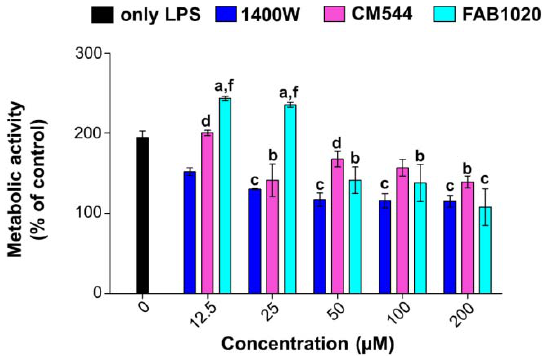
Figure 3. Cell metabolic activity of LPS-stimulated human monocytes (MTS assay). Cell cultures were exposed to 1400 W, CM544 or FAB1020 for 24 h. Bars represent the percentages of cell metabolic activity in the presence of compounds (0–200 µ M) in human monocytes stimulated with 0.25 µ g/mL of LPS. OD values in control cultures (untreated cells, not shown) are set to 100%. 0 µ M = cells stimulated with LPS alone. a = p < 0.01, b = p < 0.001 and c = p < 0.0001 between LPS-stimulated cells and treated with compounds and LPS-stimulated cells (0 µ M); d = p < 0.01 and f = p < 0.0001 between LPS-stimulated cells treated with 1400 W, CM544 or FAB1020 at the same